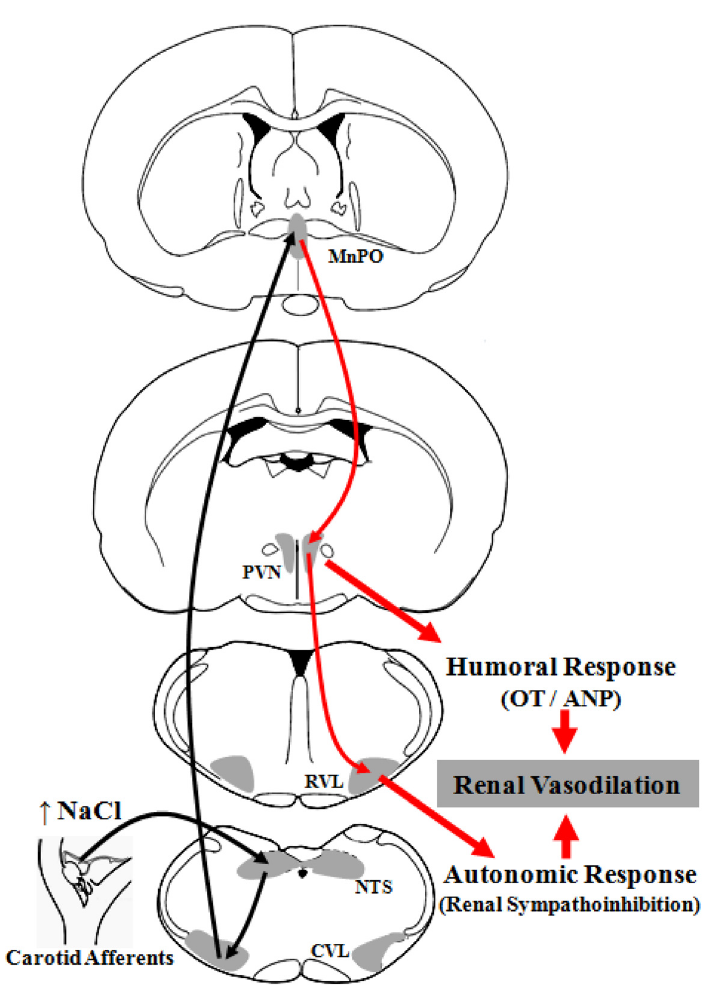
Figure 1. Schematic representation of the neural pathways involved in the con- trol of autonomic, humoral and cardiovascular adjustments induced by peripo- heral hypernatremia. MnPO = median preoptic nucleus; PVN = paraventricular nucleus; RVL = rostral ventrolateral medulla; CVL = caudal ventrolateral medulla; NTS = nucleus of the solitary tract; OT = oxytocin; ANP = atrial natriuretic pep-